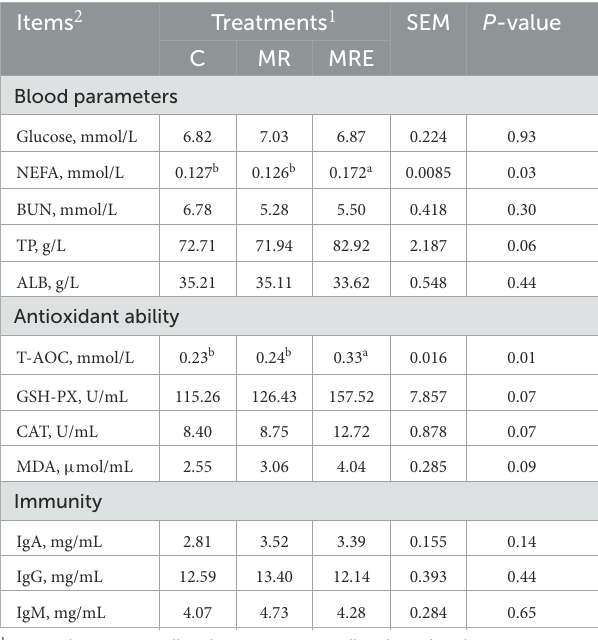
TABLE 4 Effects of milk, milk replacer and milk replacer plus ethoxyquin on blood metabolites of Holstein calves ( N = 11.9, and 11 in C, MR, and MRE, respectively).